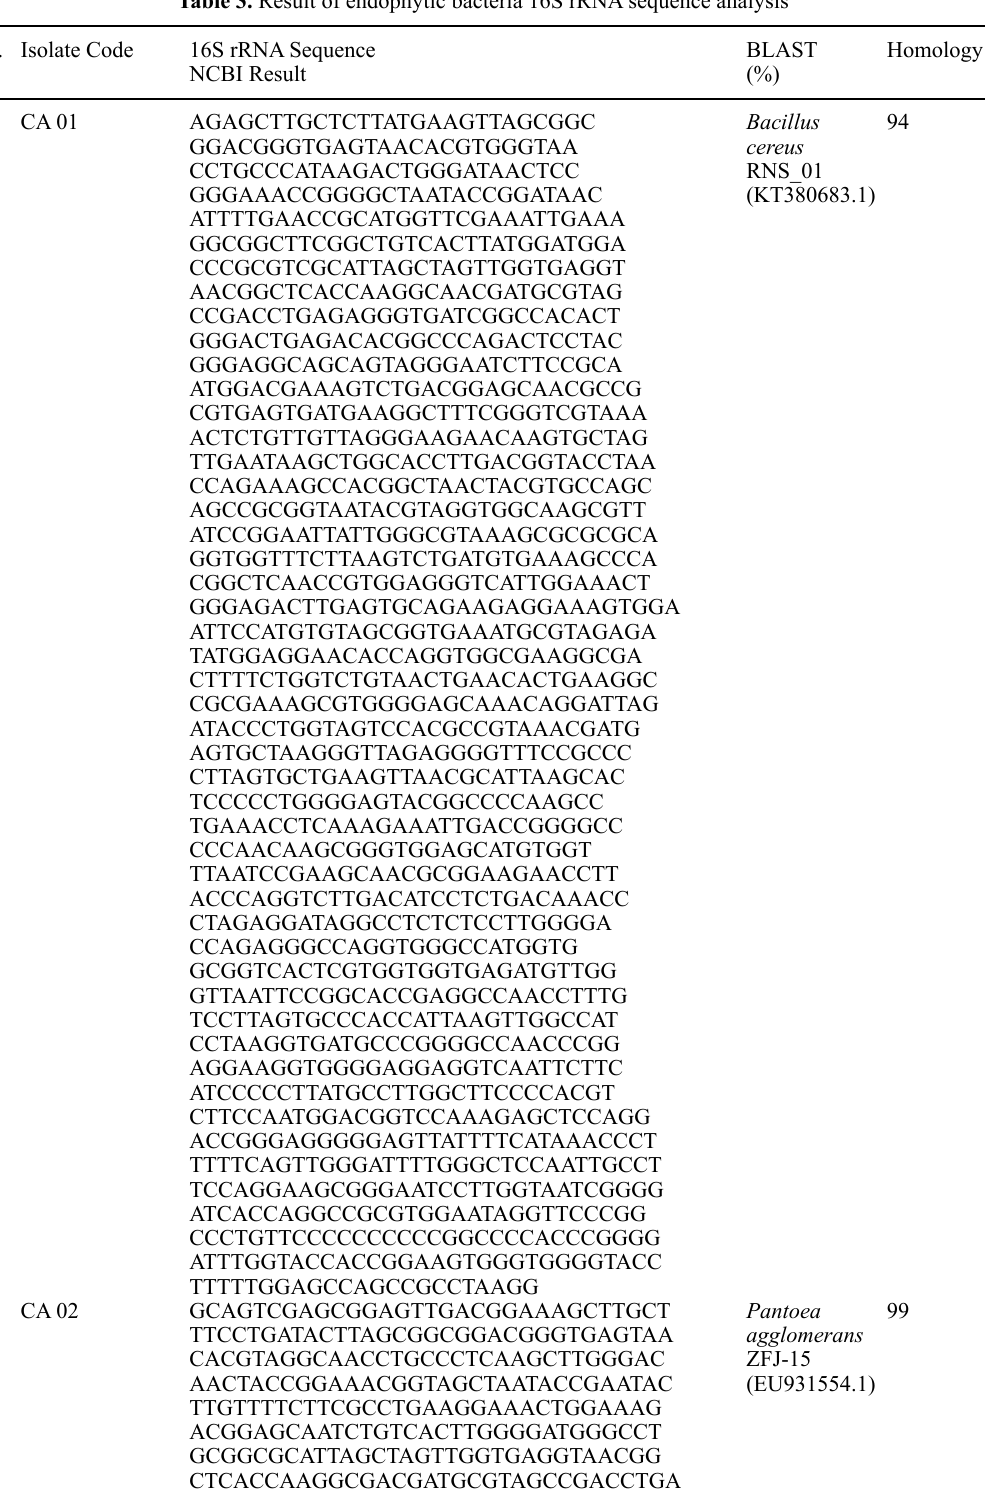
Table 3. Result of endophytic bacteria 16S rRNA sequence